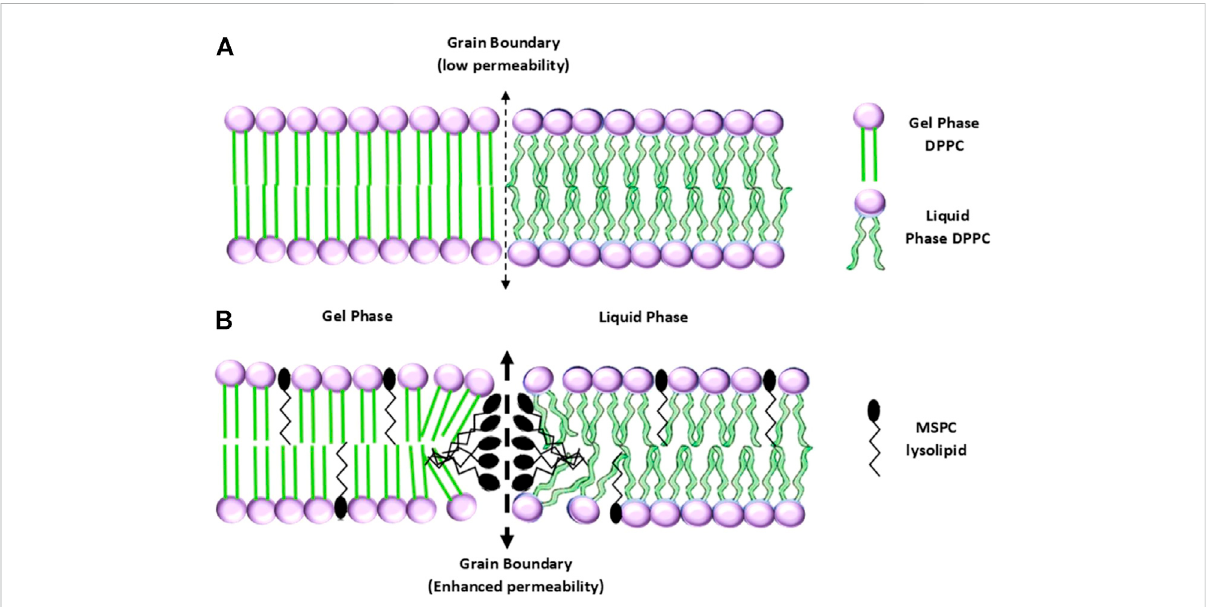
FIGURE 5 (A) Con fi gurations of a TTSL (up) and an LTSL (down) before, and (B) after the transition from gel to liquid phase (Abuwatfa et al., 2022). No permission is